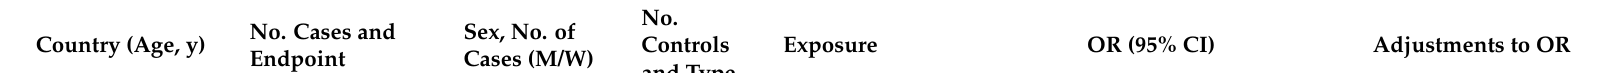
Table 5. Characteristics of the five case–control studies included in the systematic review examining the association between the consumption of fish, white meat, and eggs and the risk of colorectal